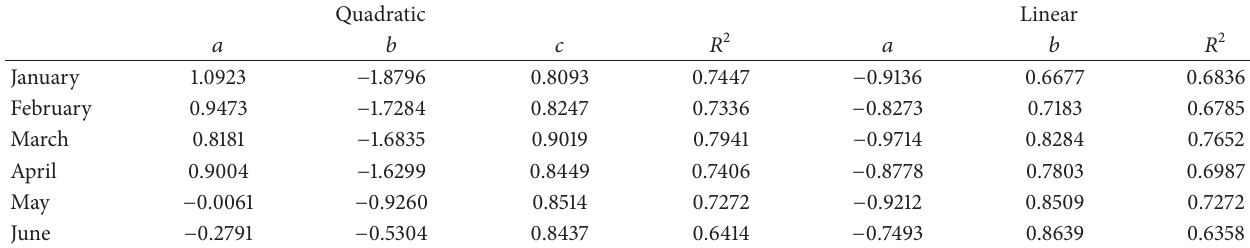
Table 1: Regression coefficients and coefficients of determinations of quadratic and linear models for each month. Quadratic